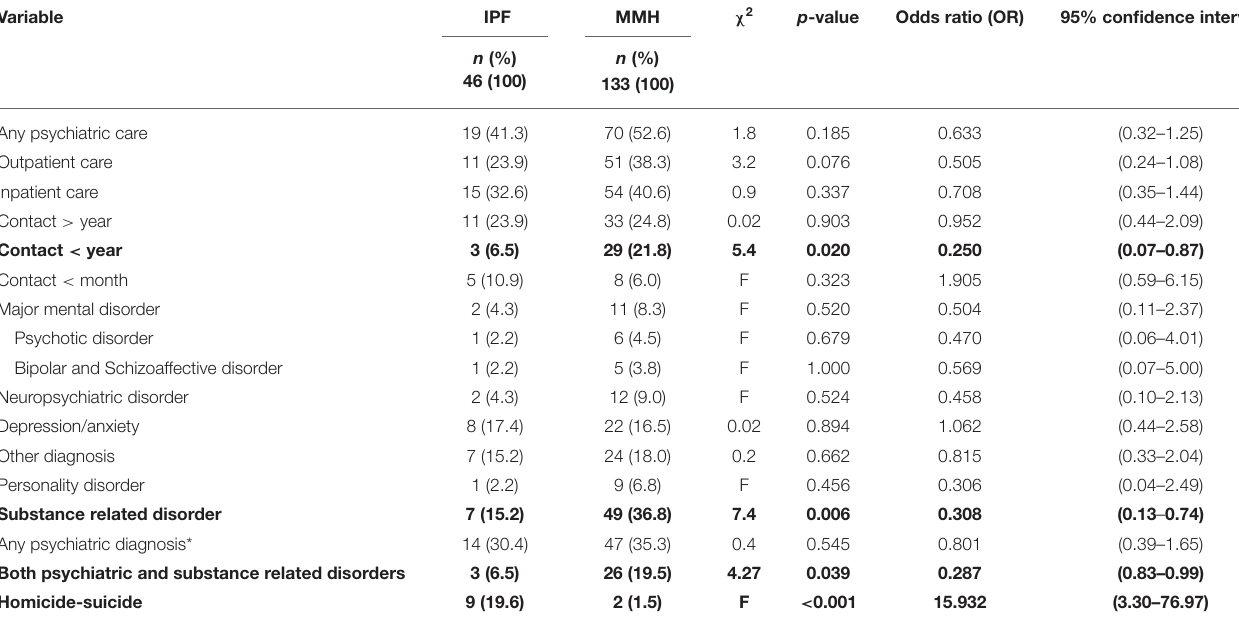
TABLE 1 | Clinical characteristics in intimate partner femicide (IPF) and male-to-male homicide (MMH) perpetrators prior to the incident (national patient registry). Variable